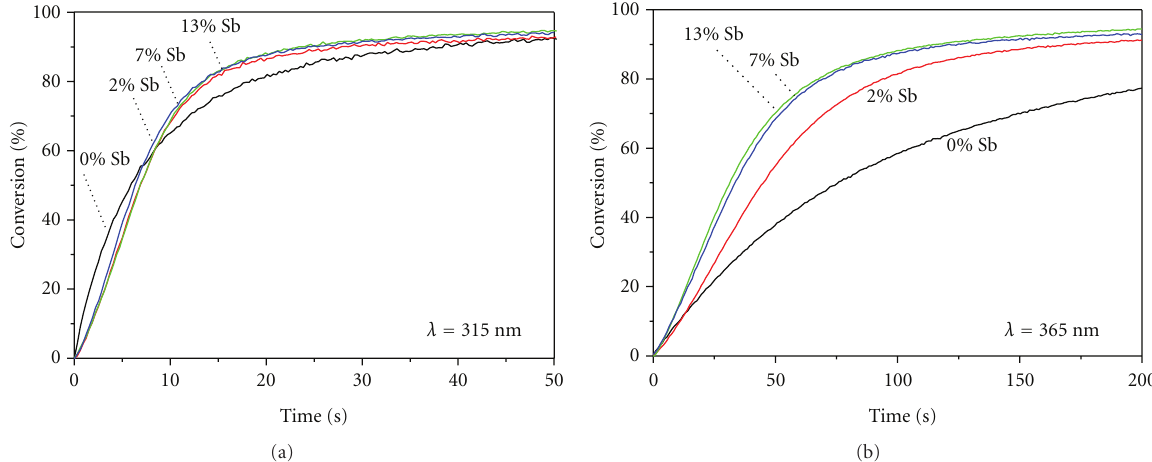
Figure 6: Influence of the Sb-doping level of the nanoparticles on the conversion % of the C = C bonds over time measured at 1637 cm − 1 . (a) λ = 315nm; (b) λ = 365nm.